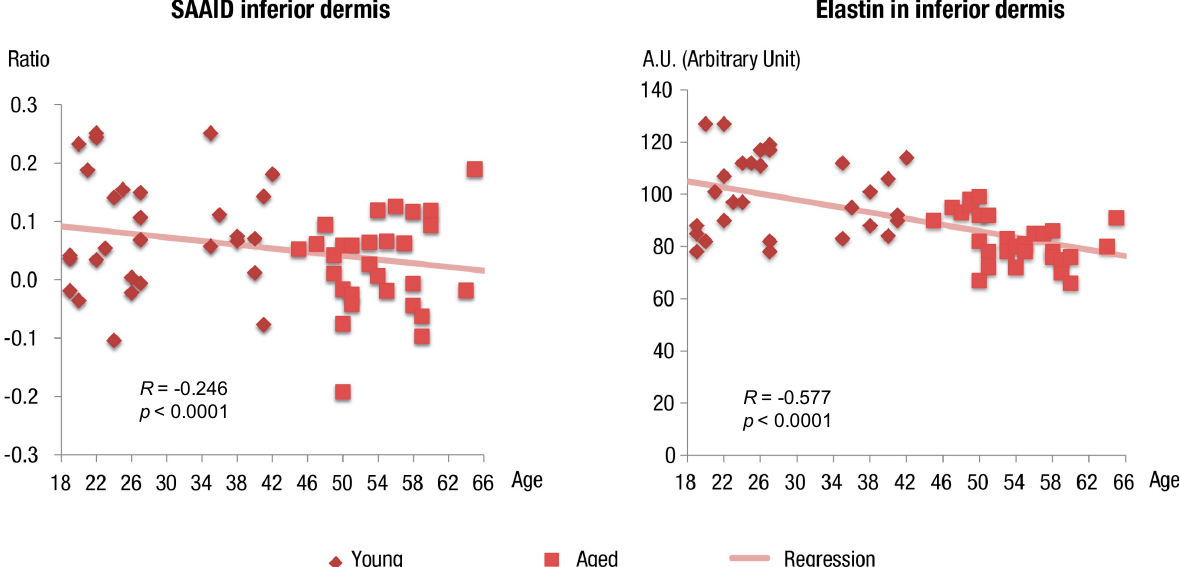
Figure 4. Evolution of SAAID and elastin with aging in the inferior dermis. Relationship between SAAID, elastin autofluorescence and age. The regression line shows the signals as a function of age. R = Pearson coefficient of correlation, p value indicates the significance level of correlation.